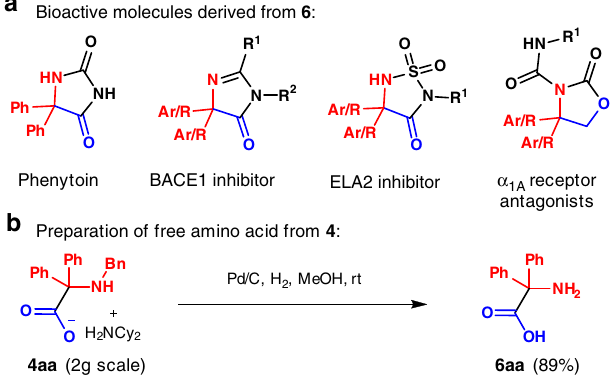
Fig. 6 Applications of α , α -diaryl α -amino acids. a Potential targets and b deprotection of amino acid derivative 4aa on 2 gram scale